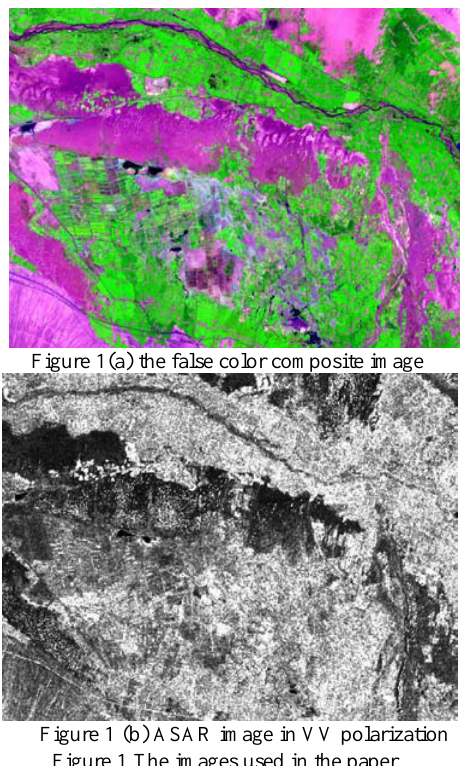
Figure 1 (b) ASAR image in VV polarization Figure 1 The images used in the